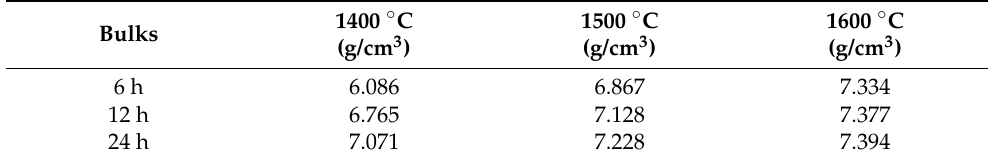
Table 4. The sintered Gd 2 O 3 bulks’